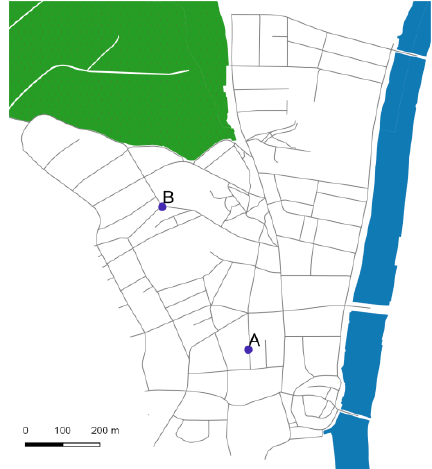
Figure 3: Study Perimeter with test locations A and B. (Data Sources: Amt für Geoinformation Kanton Solothurn 2016)